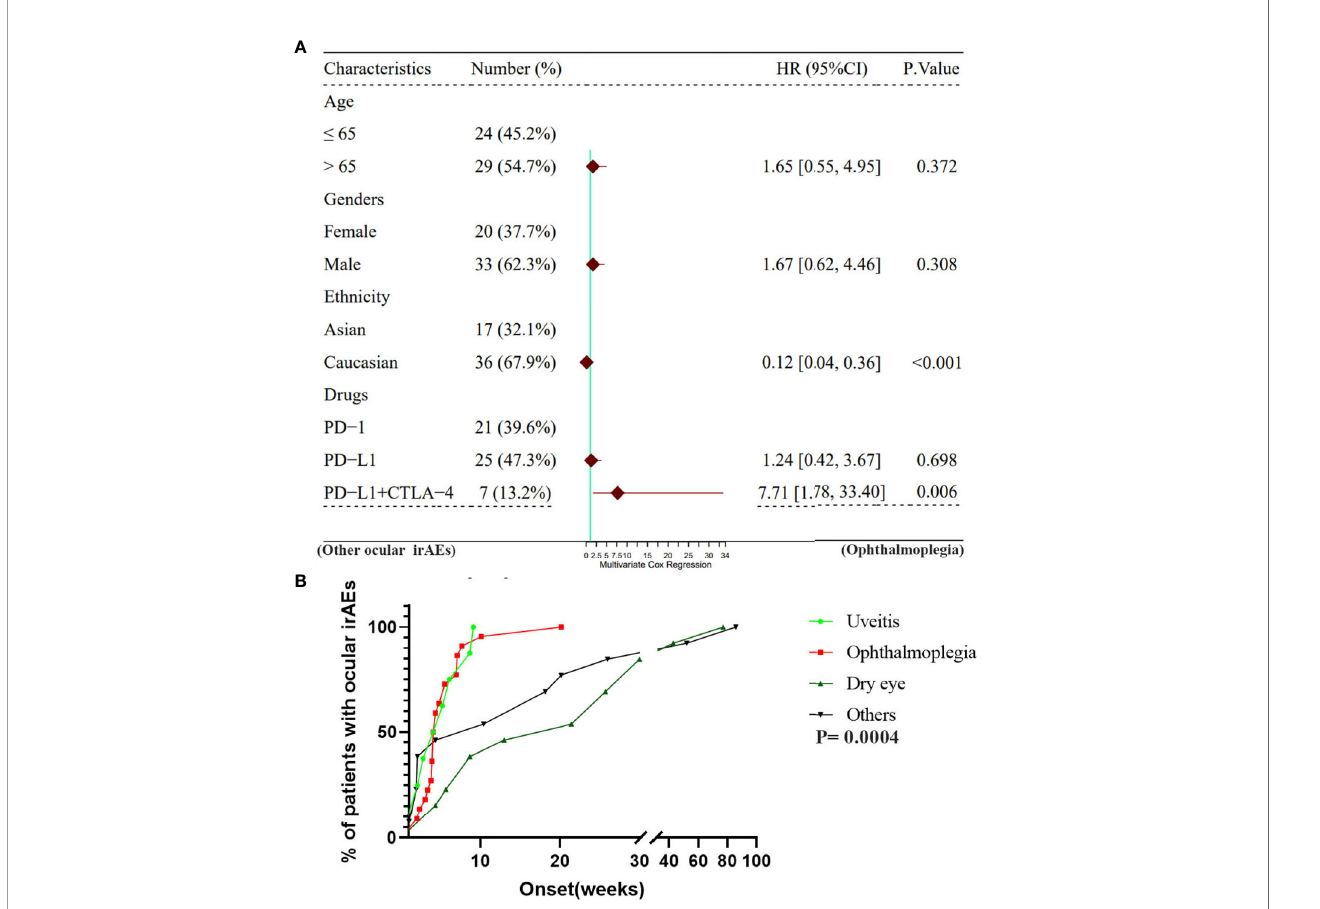
FIGURE 3 | (A) A multivariate cox regression analysis for the ocular irAEs among age, gender, ethnicity, ICIs drugs. (B) A comparison of the onset time of ocular irAEs among ophthalmoplegia, uveitis, dry eye, and other ocular